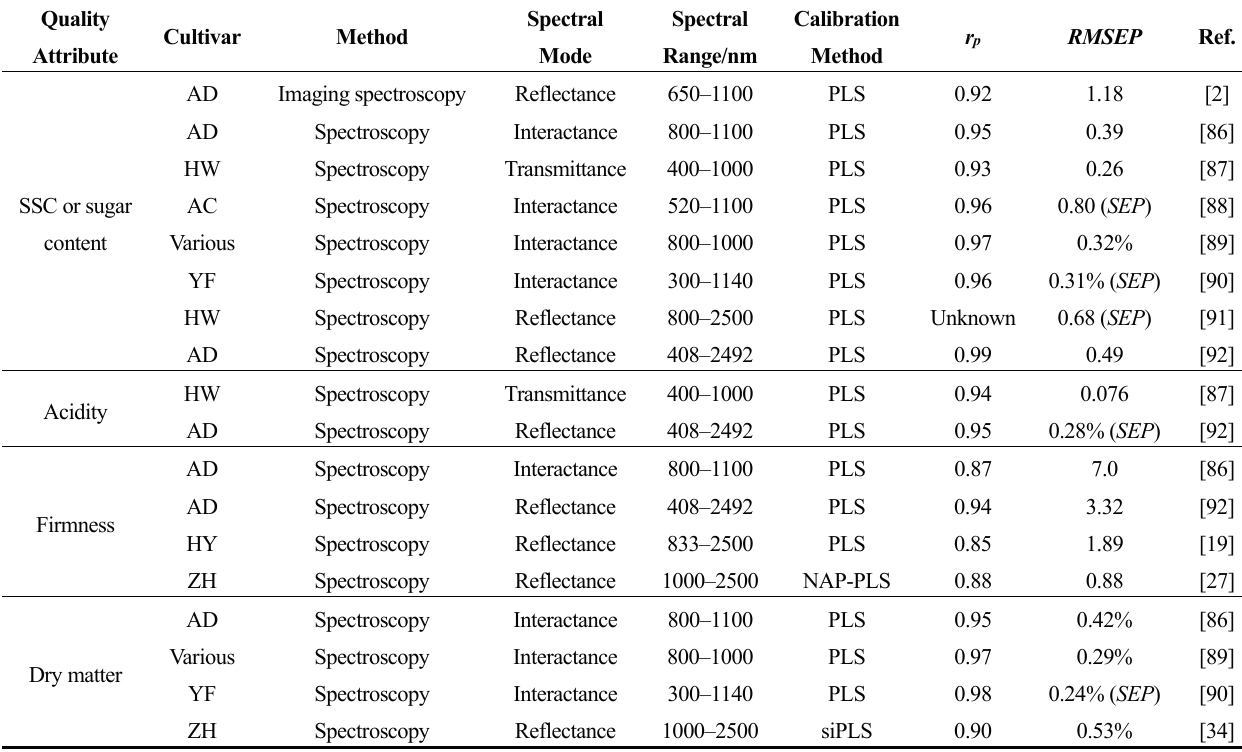
Table 4. Overview of applications for measuring quality attributes in